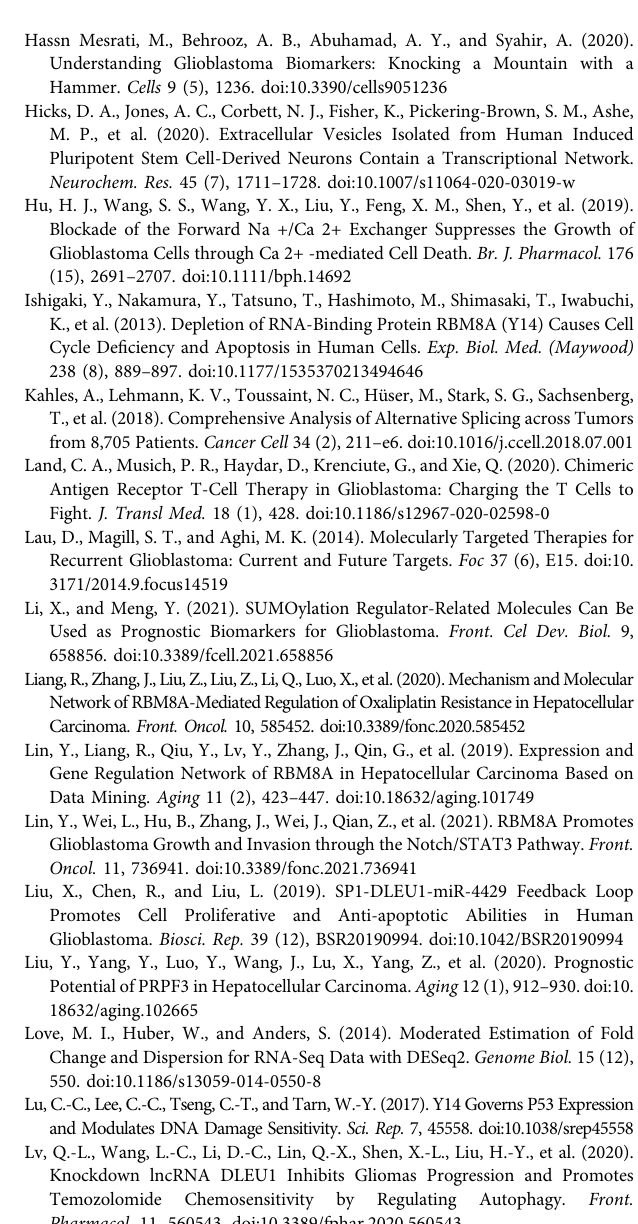
Supplementary Figure S2 | Association of long noncoding RNAs in the ceRNA network with overall survival of GBM patients. SupplementaryFigureS3| AbilityofcandidatemRNAstopredictoverallsurvivalat one, three or fi ve years, based on the area under receiver operating characteristic curves (AUC). Only mRNAs showing AUCs > 0.6 in TCGA are